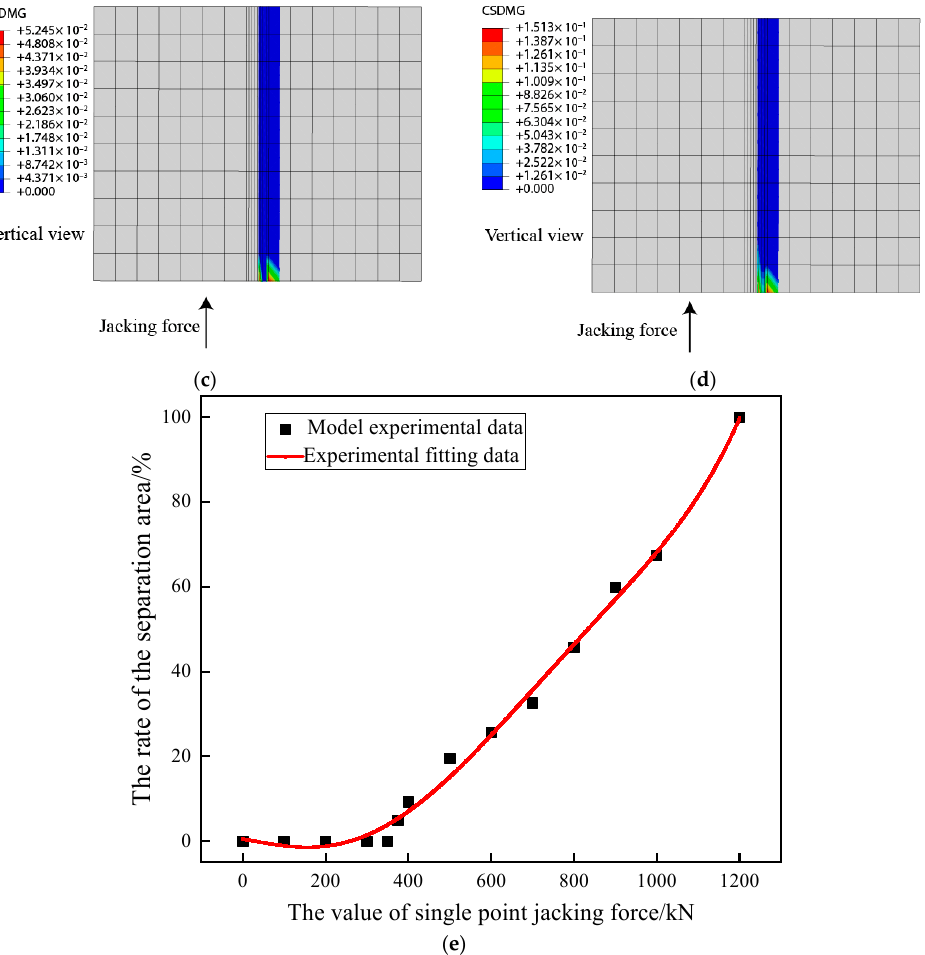
Figure 12. Effect of jacking force on damage and failure of the interface between mortar layer and wide-narrow joint, ( a ) 300 kN jacking force; ( b ) 350 kN jacking force; ( c ) 375 kN jacking force; ( d ) 400 kN jacking force; ( e ) The ratio of the separated area to the total interface area when different jacking forces are applied. A series of numerical simulations are carried out to study the influence of